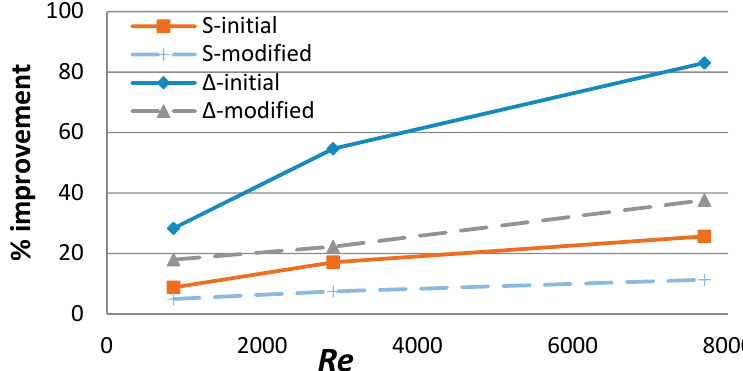
Figure 11. Comparison of predicted flow distribution in the initial and modified collector